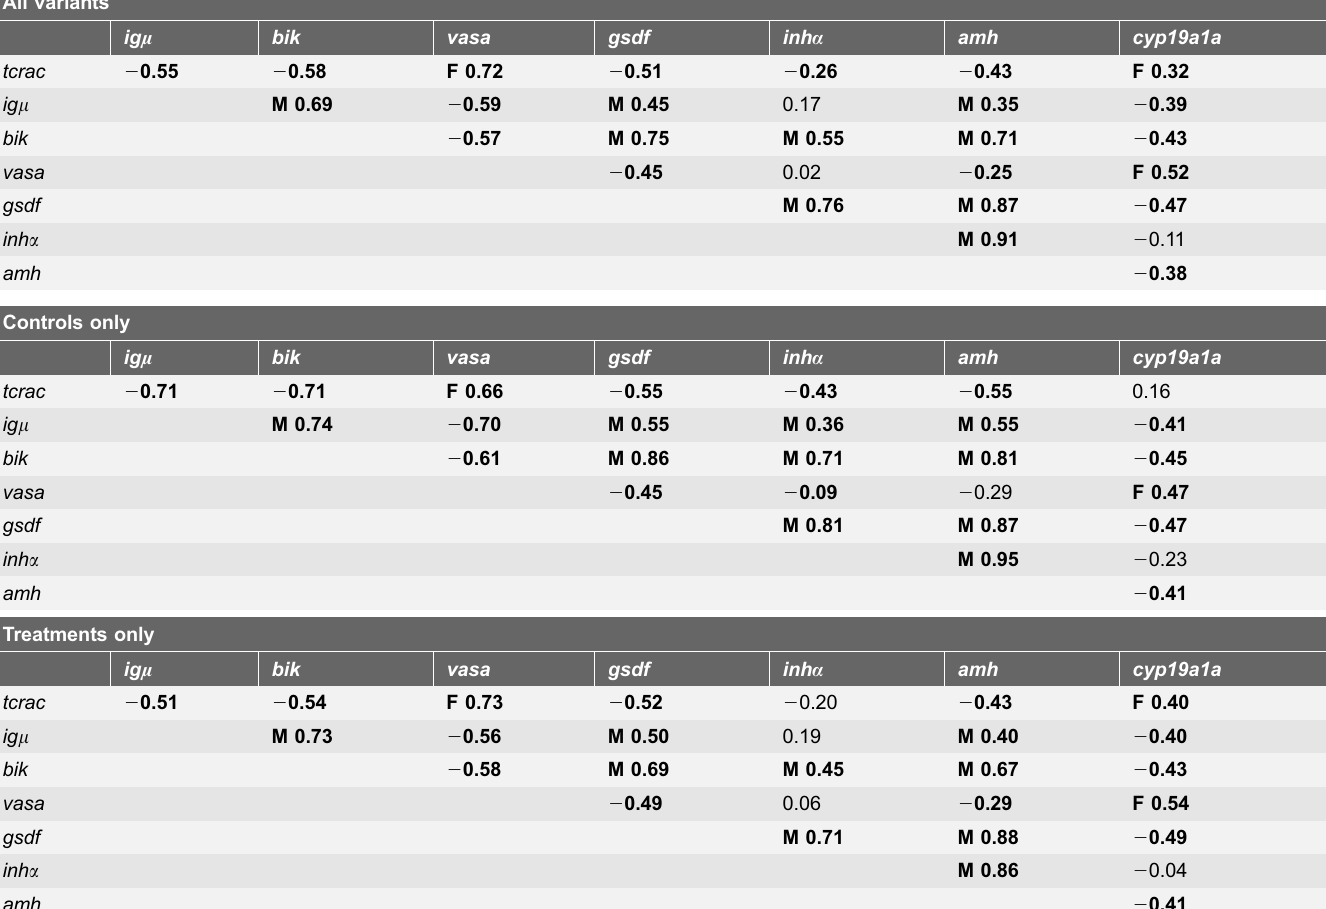
Table 2. Correlations (Pearson’s r ) between the relative expressions of the investigated genes.